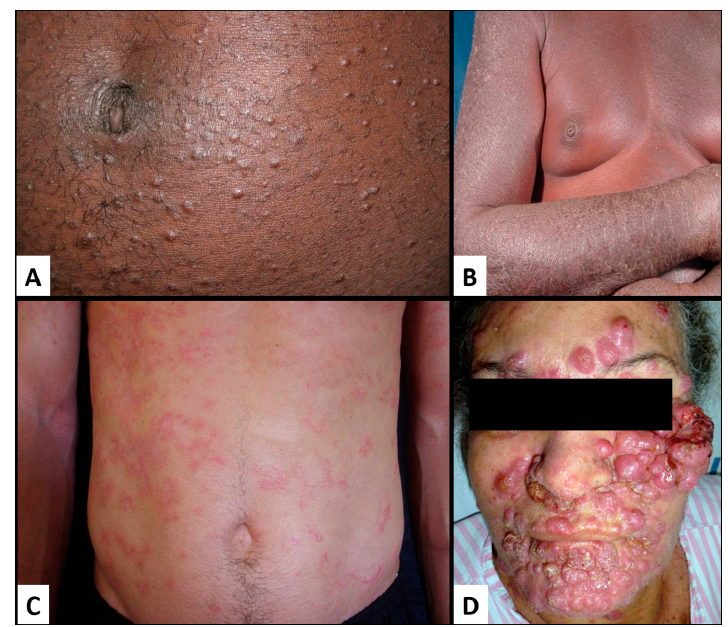
Figure 7. Examples of cutaneous lesions observed in ATL. ( A ) Chronic form with papular pattern; ( B ) Acute form showing exfoliative erythroderma; ( C ) Smoldering form with a pattern of papules and erythematous scaly plaques; ( D ) Primary cutaneous tumoral form. Reproduced with permission from Oliveira P.D., Adult T-cell leukemia/lymphoma; published by Rev. Assoc. Med. Bras. , 2016 .